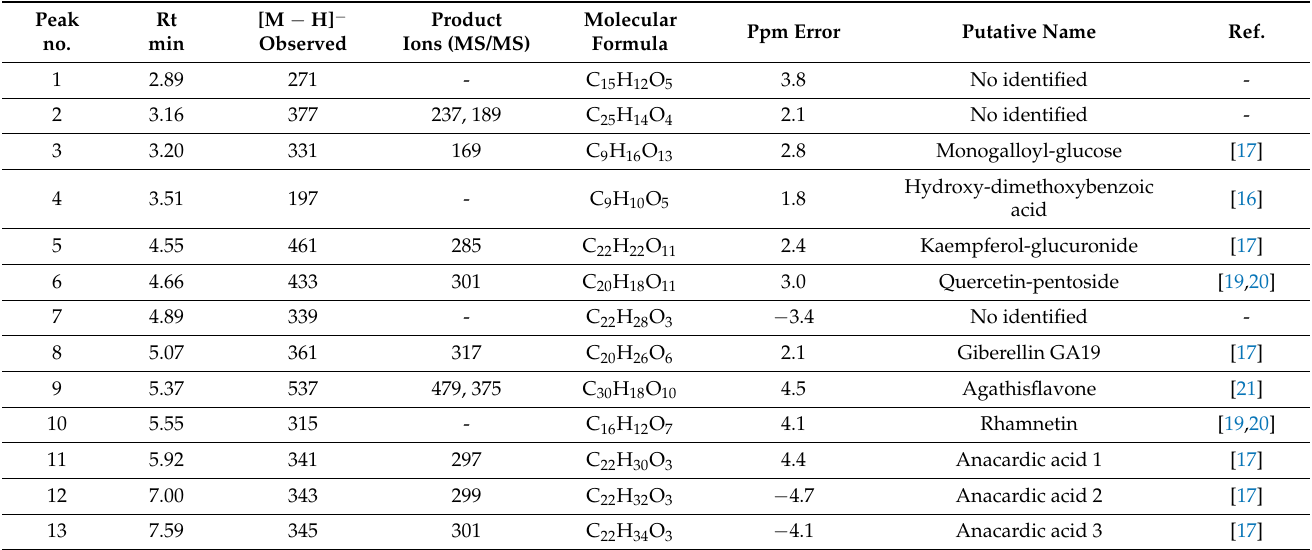
Table 3. UPLC-MS-ESI-QTOF identification of compounds from aqueous roots extract of Spondias tuberora (Negative